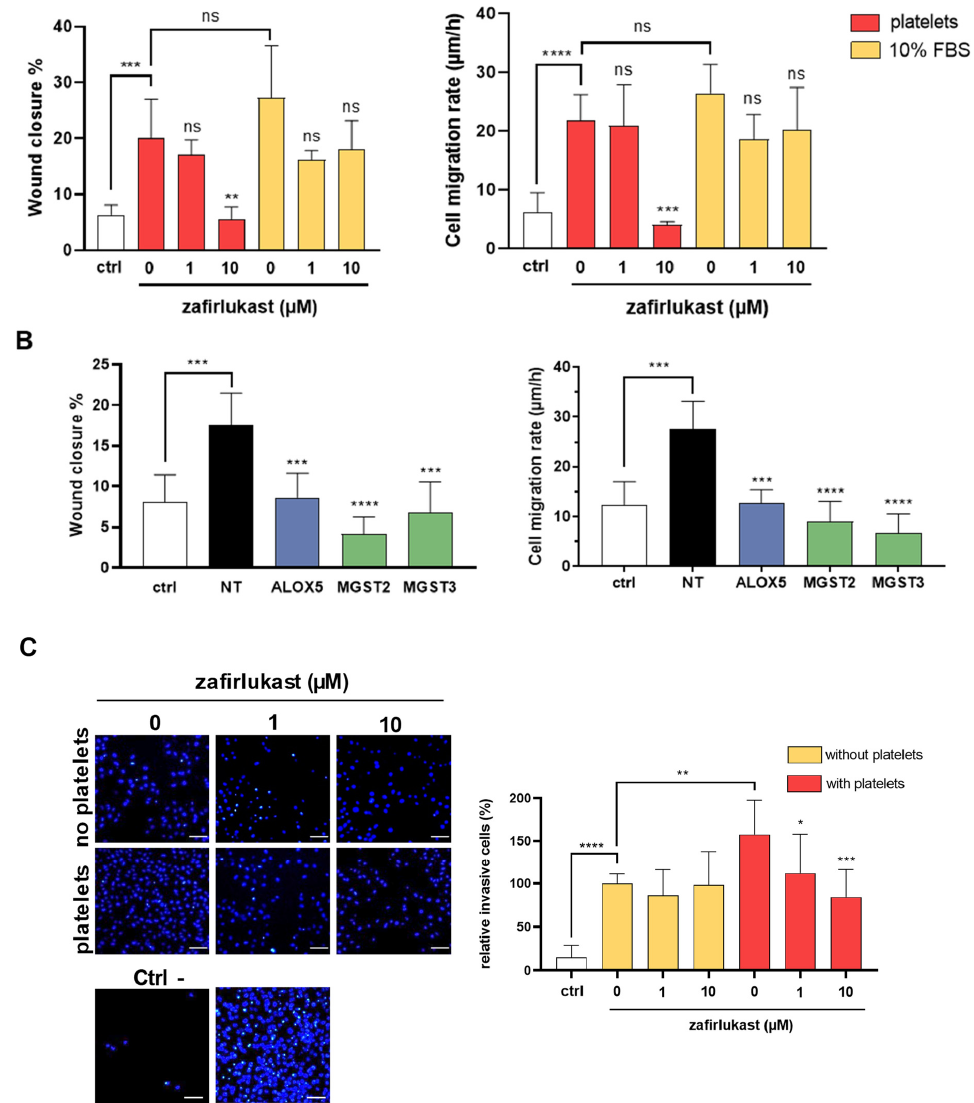
Figure 5. Platelet CysLT1R contribute to platelet-induced MDA-B02 breast cancer cell invasive phenotypes. ( A ) Representative bright-field images of a wound healing assay showing that zafirlukast at 10 µ M prevents platelet-induced migration of MDA-B02 cells but not serum-induced migration. Scale: 100 µ m. Wound closure (%) is expressed as the remaining area uncovered by the cells at h = 5. Cell migration rate ( µ m/h) is calculated from the measure of wound width. The data represent the mean ± SD (n = 3) and the platelets come from two different donors. The control group (ctrl) is cultivated in absence of platelet and FBS. ( B ) The inhibition of tumoral CysLT production by MDA-B02 cells transfected with siRNA targeting ALOX5, MGST2, or MGST3 inhibited platelet- induced cancer cell migration as measured by the decrease of wound closure and cell migration rate ( µ m/h) after 5 h of co-culture in presence of human platelets. The control group (ctrl) was cultivated in absence of platelets and FBS. NT = Non-transfected cells. ( C ) Effect of zafirlukast on the platelet-induced invasion activity of MDA-B02 cells. Cells were cultured in 0.1% BSA and allowed to invade Matrigel ® chambers for 48 h in presence or absence of platelets and zafirlukast. Media supplemented with 1% FBS was used as a chemoattractant in the lower chamber, with 0.1% BSA for the negative control wells (ctrl -), or with 10% SVF for the positive control wells (ctrl +). The data represent the mean ± SD (n = 3), and the platelets comes from three different donors. Scale: 100 µ m (ns = not significant; * p < 0.05; ** p < 0.005; *** p < 0.001; **** p < 0.00001 vs. NT; one-way ANOVA). Abbreviations: ctrl = control, FBS = fetal bovine serum, NT =